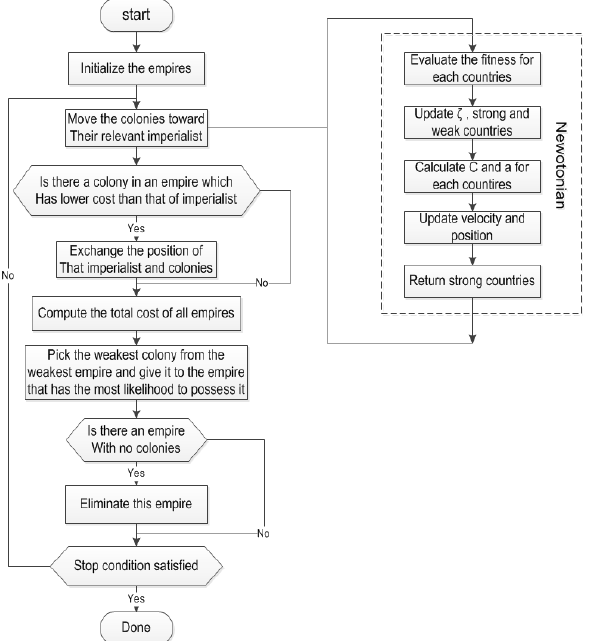
Figure 1. General principle of NICA